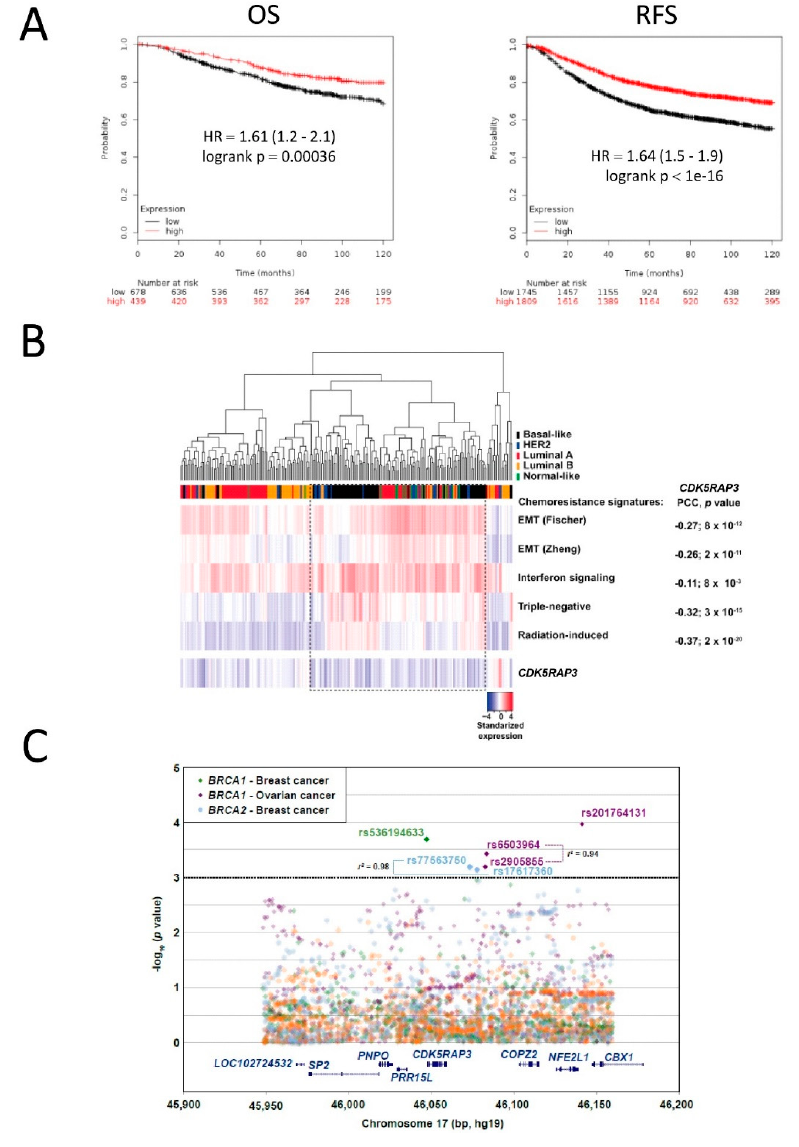
Figure 4. Low CDK5RAP3 expression is associated with poor patient survival in breast cancer. ( A ) Kaplan–Meier survival curves for 1117 (overall survival, OS, left panel) and 3554 (relapse-free survival, RFS) patients with breast cancer. Data were divided at the best cutoff value into high and low expressing groups (for RFS, n = 1745 for CDK5RAP3 low, n = 1809 for CDK5RAP3 high; p < 10–16 with log-rank analysis; for OS, n = 678 for CDK5RAP3 low, n = 439 for CDK5RAP3 high; p = 0.00036 with log-rank analysis). Data obtained from the Kaplan–Meier Plotter (http://www.kmplot.com, accessed on 3 July 2021). ( B ) Unsupervised clustering of TCGA breast cancer gene expression data of CDK5RAP3 and defined signatures of chemoresistance and/or DNA damage resistance (two sets of epithelial-to-mesenchymal (EMT)-related genes are shown, as indicated in the text). The Pearson correlation coefficients (PCCs), corresponding p values, and tumor subtypes according to PAM50 classification are also shown. The dashed box highlights the cases with relative lower expression of CDK5RAP3 and higher for the signatures. ( C ) SNPs linked to CDK5RAP3 may influence breast/ovarian cancer risk in BRCA1/2 mutation carriers. Association plot for variants within the genomic region 100 kb on either side of CDK5RAP3 and risk of ovarian and breast cancer. X-axis position is referent to position (bp) on chromosome 17. Y-axis is − log10 ( p -values) from association tests for risk of breast or ovarian cancer in BRCA1/2 mutation carriers, as shown in the